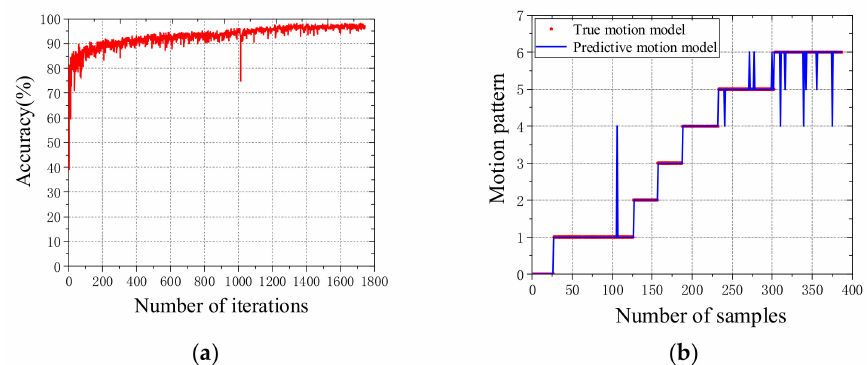
Figure 10. Training accuracy rate of the long short-term memory (LSTM) neural network. ( a ) Changes in accuracy. ( b ) Comparison of classification results with the true motion model.